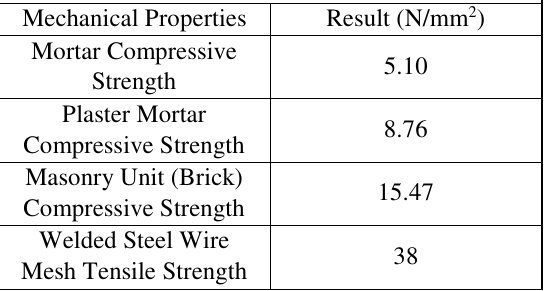
FIG. 7(B). GROUT INJECTING INTO THE WALLS THROUGH INJECTION NOZZLE